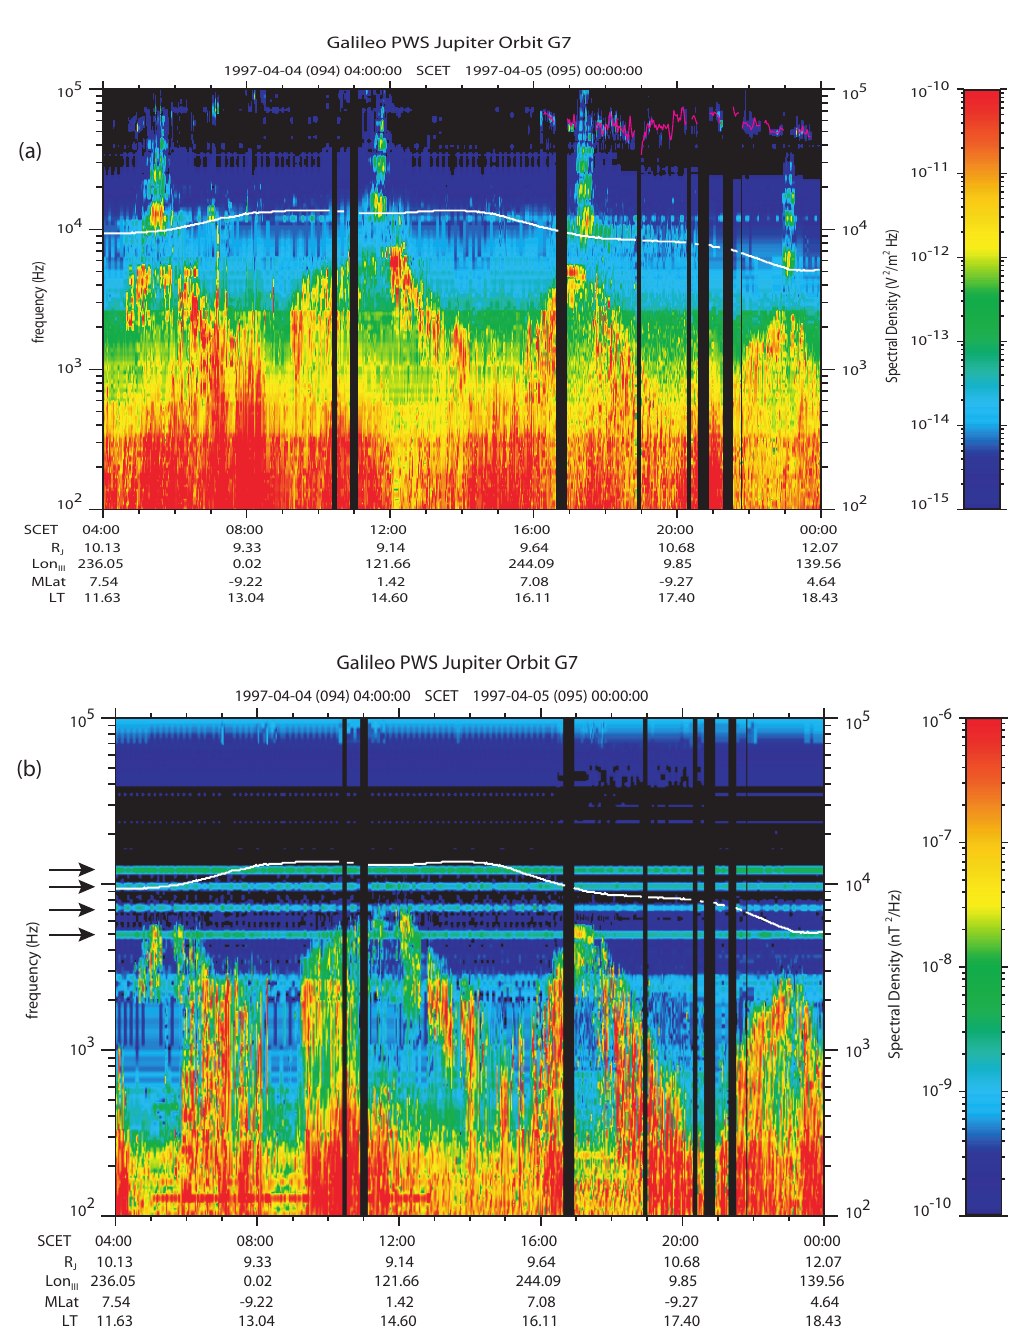
Fig. 1. An example of chorus emissions observed on orbit G7. The plot is a frequency-vs-time spectrogram over the frequency range from 100Hz to 100kHz with electric (a) and magnetic field intensity (b) color-coded as indicated in the bar at the right of each panel. The magenta line in panel (a) indicates upper hybrid